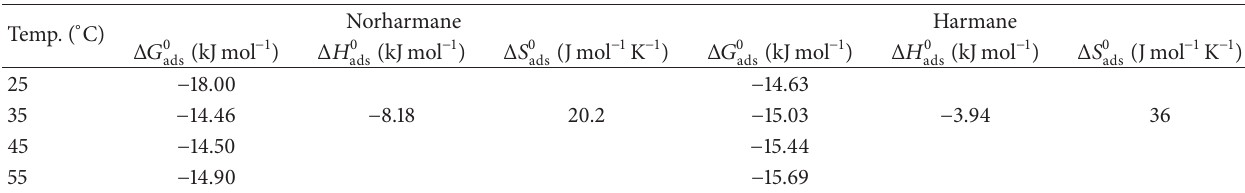
Table 7: Thermodynamic parameters calculated from IES for the adsorption of indole derivates on C38 steel in 1M HCl at different temperatures.